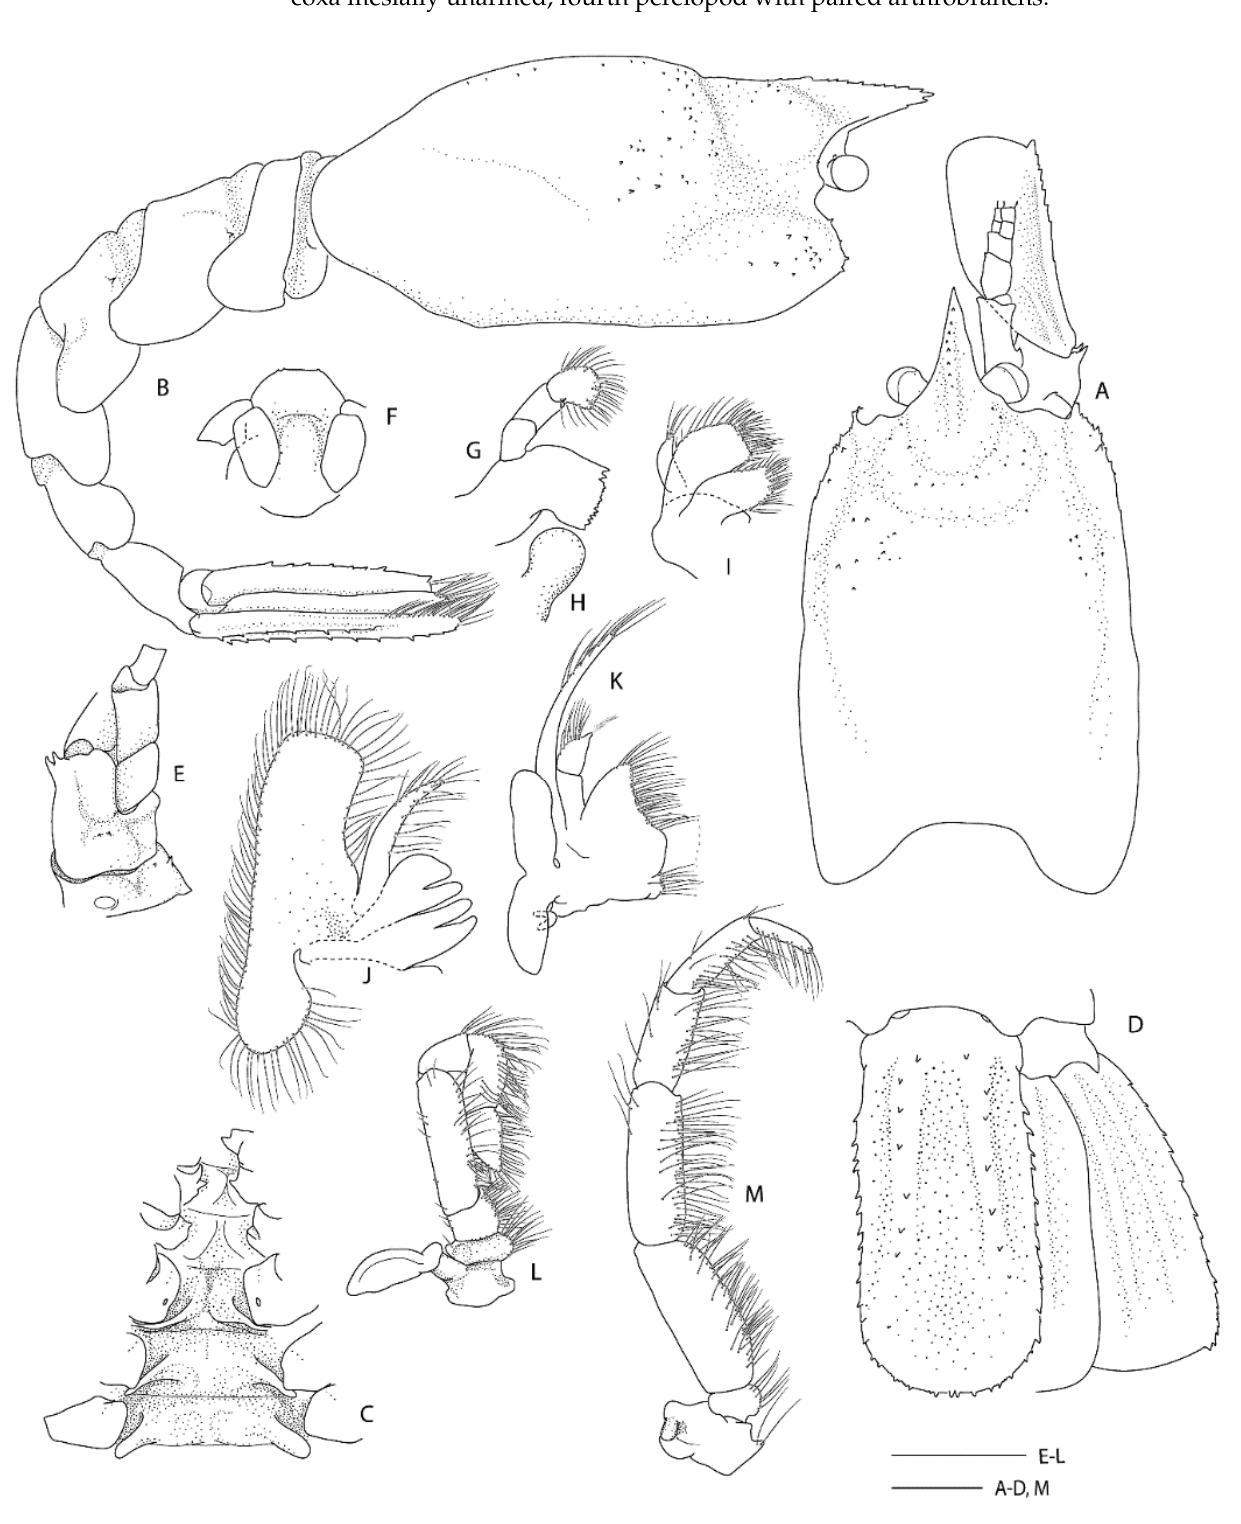
Figure 5. Spongicoloides clarki sp. nov., holotype F ov. (NIWA 118650). ( A ) Carapace and cephalic appendages, dorsal. ( B ) Carapace and pleon, lateral. ( C ) Thoracic sternites, ventral. ( D ) Telson and uropods, dorsal. ( E ) Right antennal peduncle, ventral. ( F ) Epistome and labrum showing the distal mandibular palp, ventral. ( G ) Right mandible, ventral. ( H ) Right paragnath, ventral. ( I ) Right maxillule. ( J ) Right maxilla. ( K ) Right Mxp1. ( L ) Right Mxp2. ( M ) Right Mxp3. Scale bars = 2 mm.